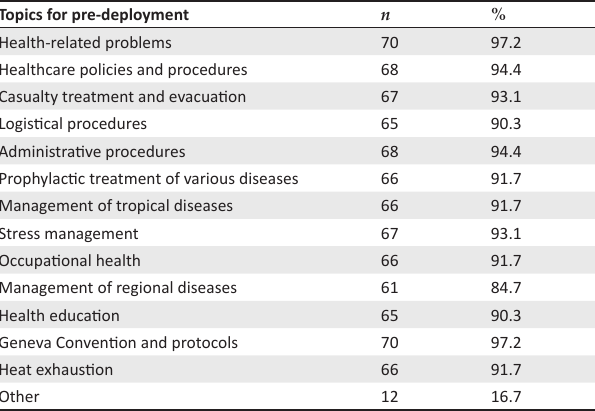
TABLE 1: Suggested topics for pre-deployment programme confirmed by the respondents ( n =